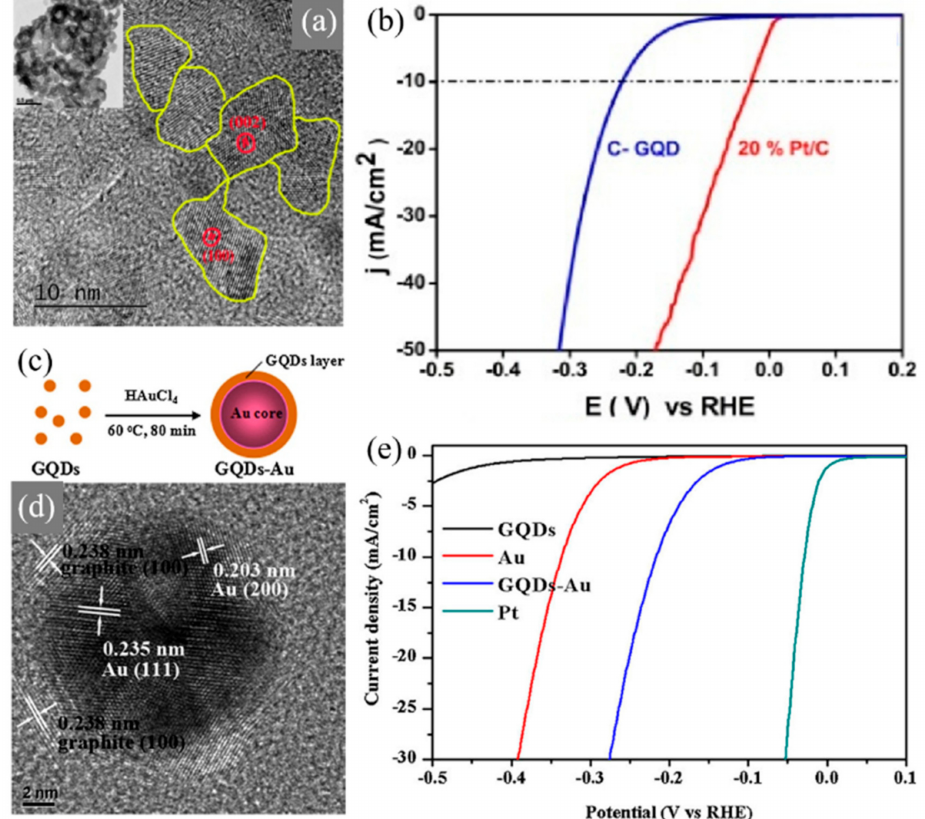
Figure 6. Graphene quantum dots (GQDs) applied in electrochemical cells for water splitting reactions. ( a ) HRTEM image of inter-connected graphene quantum dots (c-GQDs), inset shows low magnification image of c-GQDs. ( b ) Polarization curve for 20% Pt / C and c-GQDs [73]. ( c ) Schematic illustration of the strategy for GQDs-Au preparation. ( d ) TEM image of single GQDs-Au. ( e ) Polarization curves obtained with several catalysts as indicated